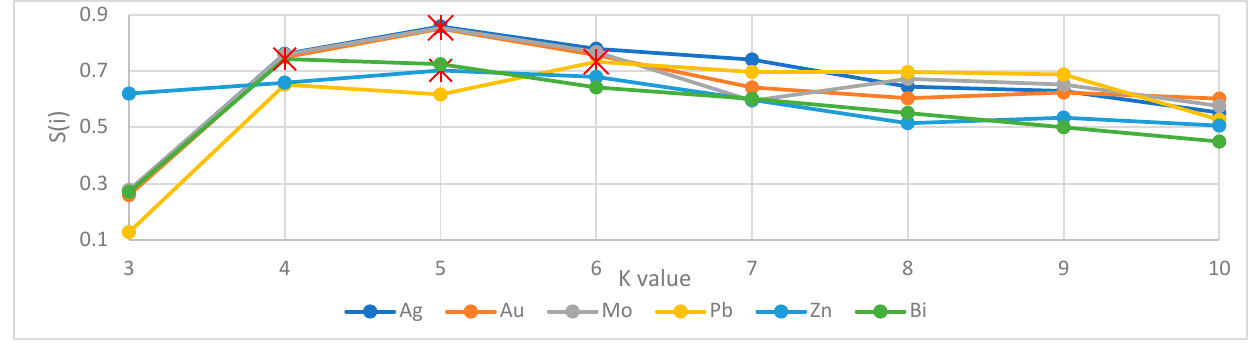
Figure 10. A graph of the utility function S (i) value versus the number of clusters for the Cu versus Ag, Au, Mo, Pb, Zn and Bi.